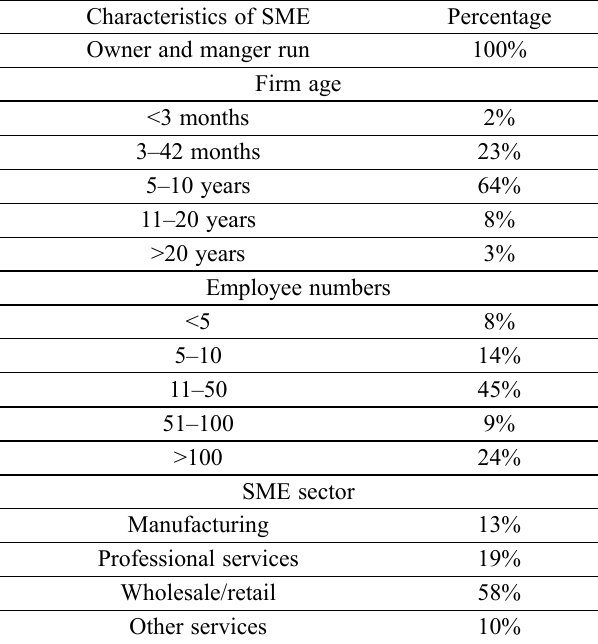
Table 1. Profile of